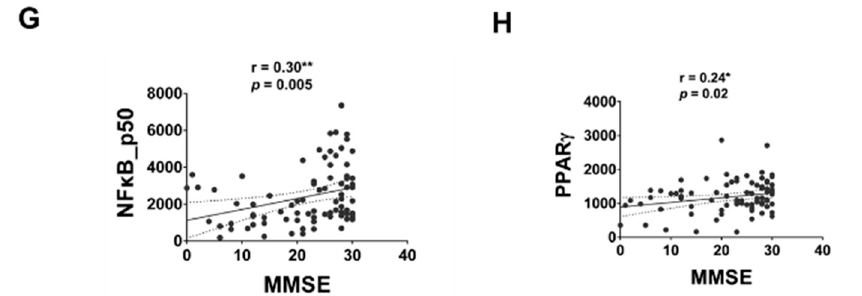
Figure 6. The correlation of expression levels of serum protein and MMSE. The relative expression level of serum proteins and MMSE of the 31 HC, 30 AD and 30 ACS were pooled together for Pearson’s correlation test. A two-tailed p -value of < 0.05 was considered to indicate a statistical significance. Proteins with statistically significant correlation with MMSE was shown for ApoE ( A ), c_Myc ( B ), LATS1 ( C ), MST1 ( D ), MST2 ( E ), Nanog ( F ), NF κ B_p50 ( G ) and PPAR γ ( H ). Asterisks *, **, *** represented